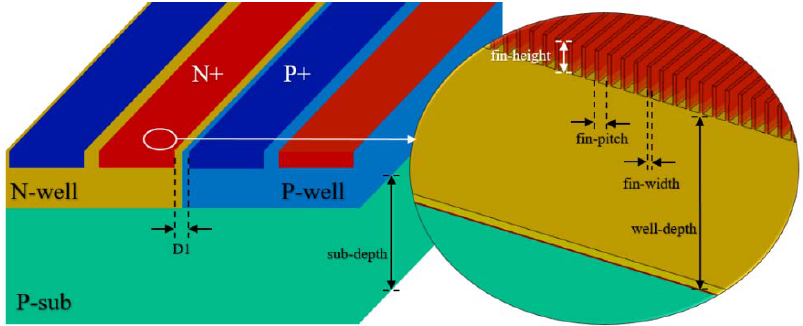
Figure 4. SCR ‐ D parameters in TCAD simulation; enlarged view of Fin structure.